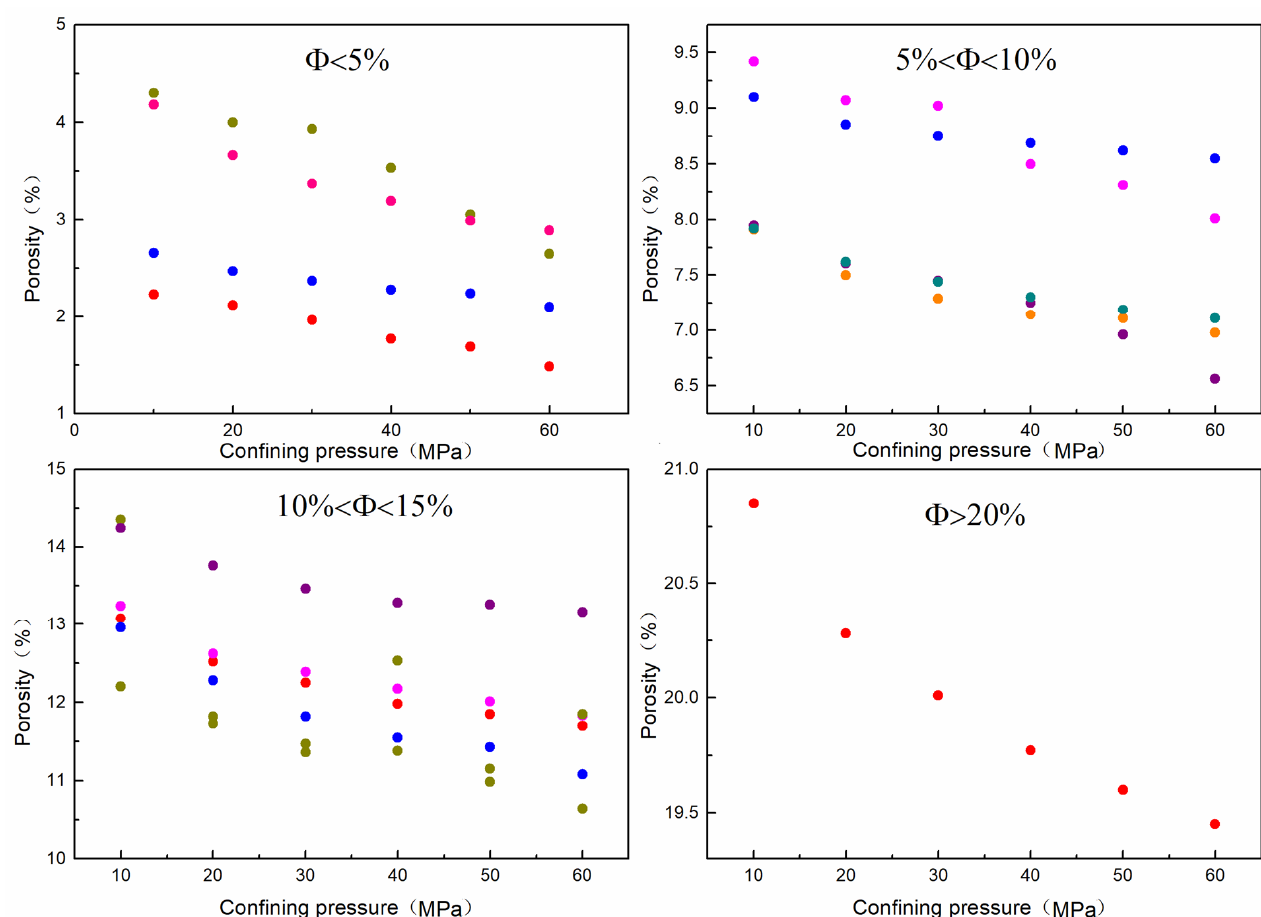
Figure 5. Cross-plot of porosity and confining pressure (different color dots represent different samples).